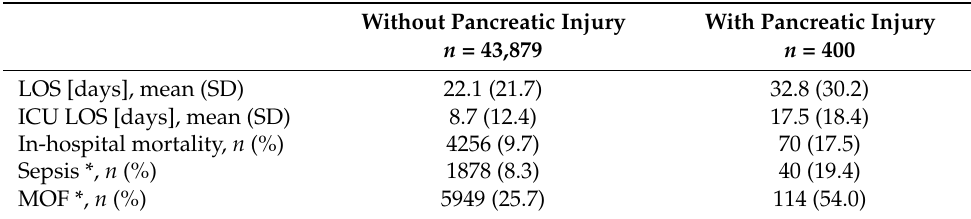
Table 2. Outcome parameters.